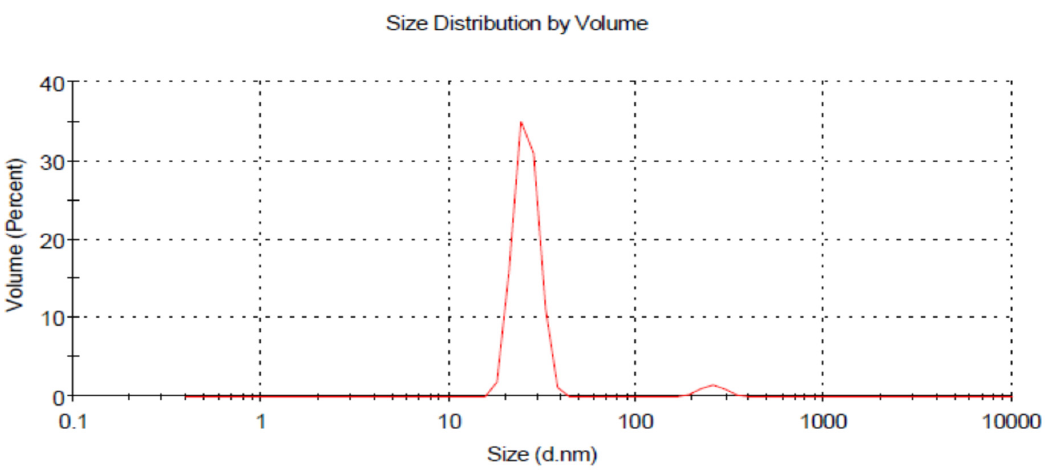
Figure 4. Z average size of SA NPs, 26.6 nm.